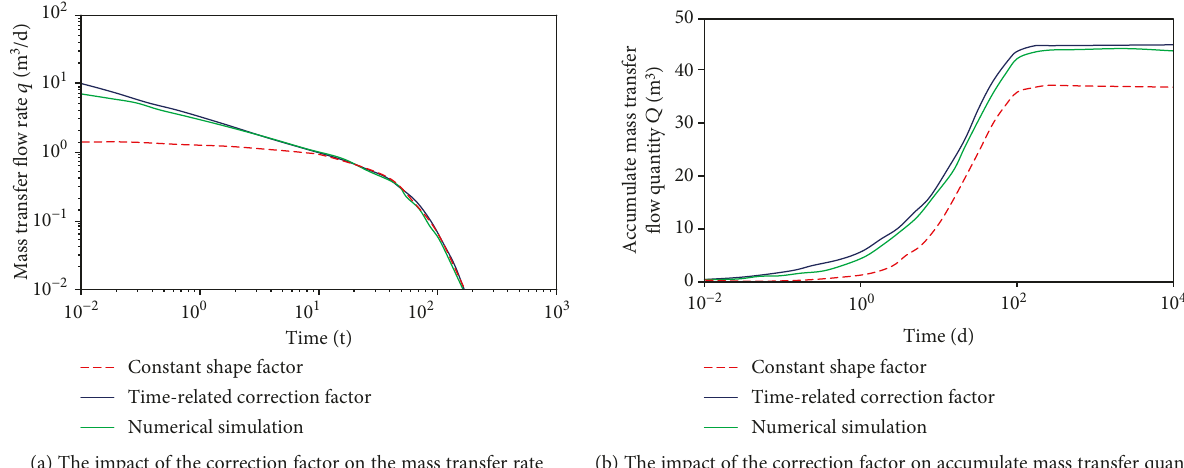
Figure 11: The impact of the mass transfer fl ow correction factor to the fl ow